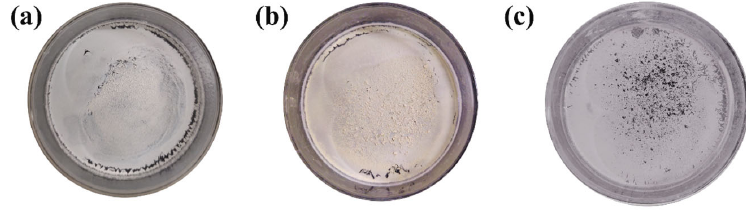
Figure 1. Optical images of BNO ( a ), 2 ‐ BNO ( b ) and 2%Bi ‐ 2 ‐ BNO ( c ).